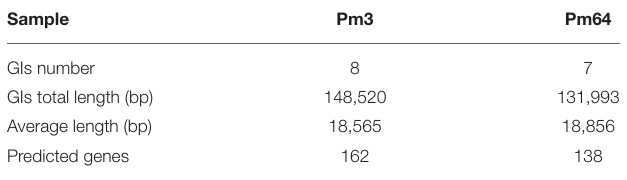
TABLE 1 | Gene islands (GIs) prediction results